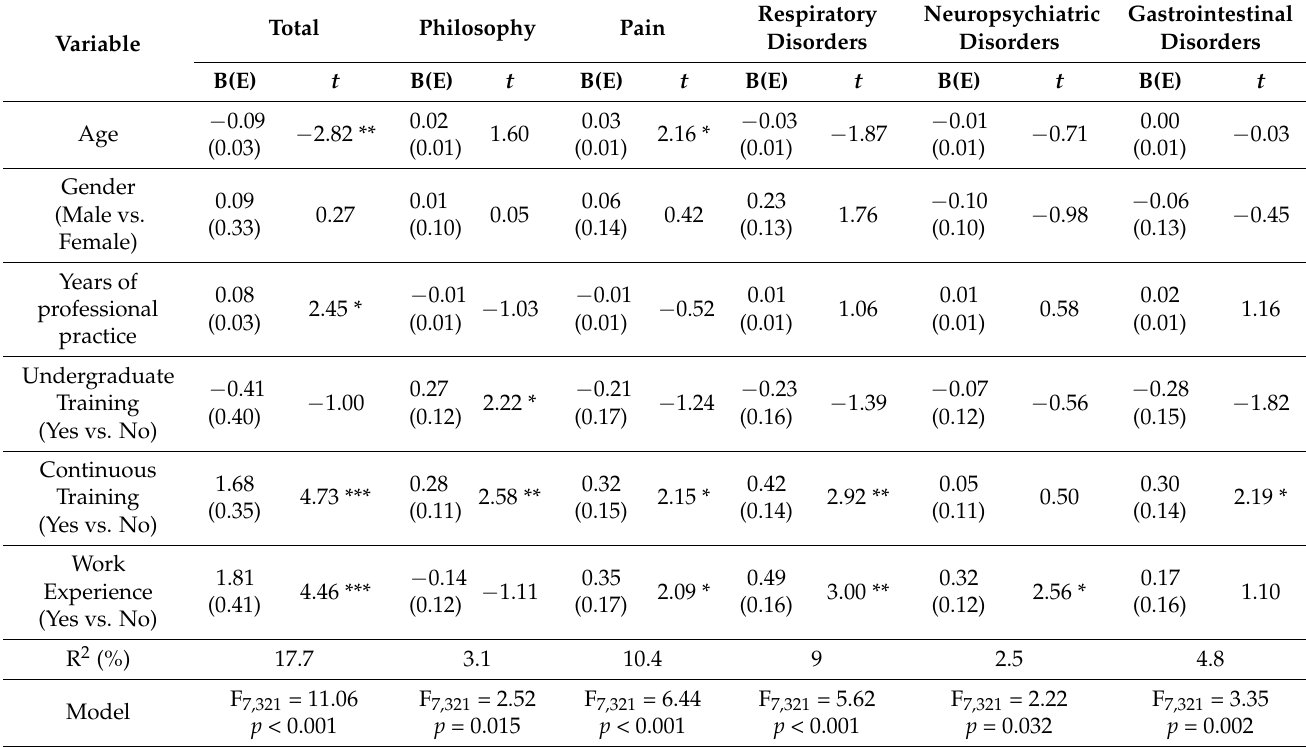
Table 6. Multiple-dimensional regression models of the Palliative Care Knowledge Test-Spanish Version in physicians.